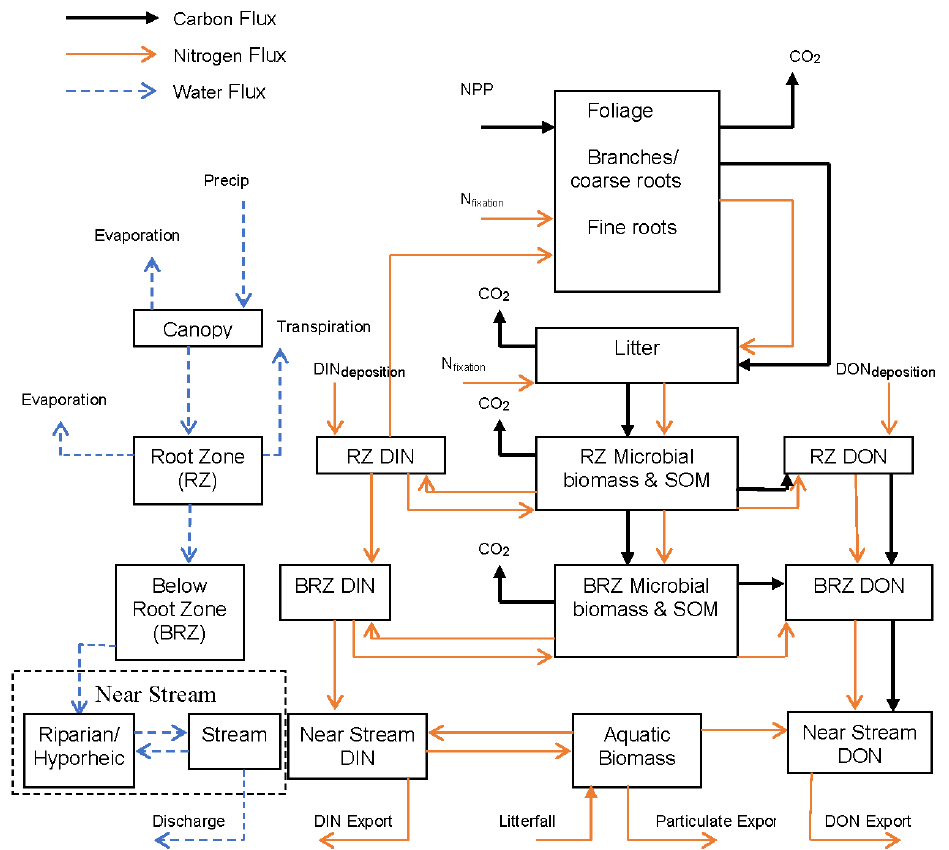
Figure 1. A flow chart outlining key model stocks and fluxes. Some minor flux terms